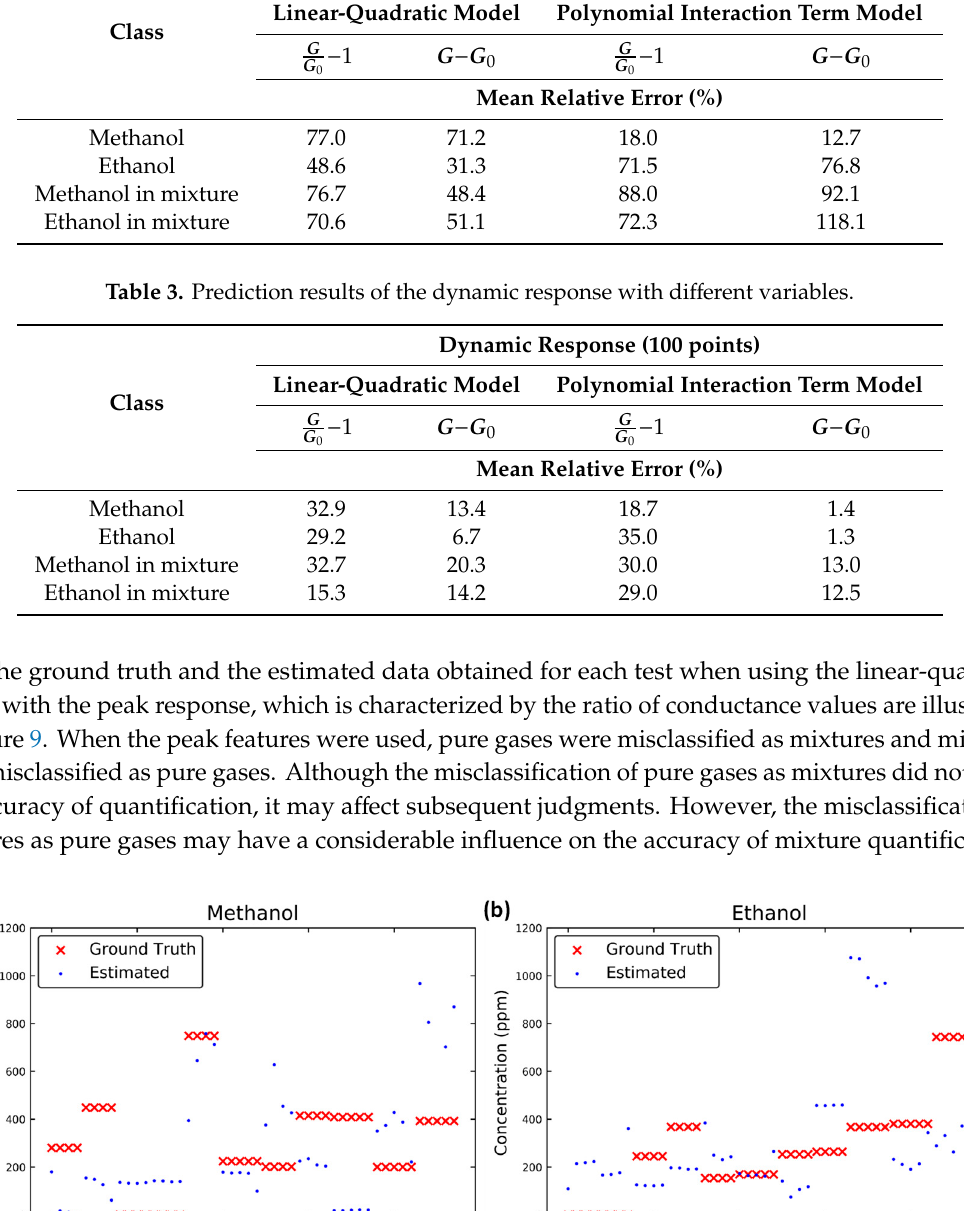
Table 2. Prediction results of the peak response with di ff erent variables.